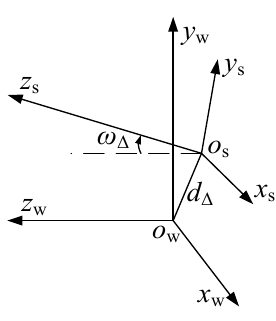
Figure 7. The position relationship between O s - Z and O w - Z .